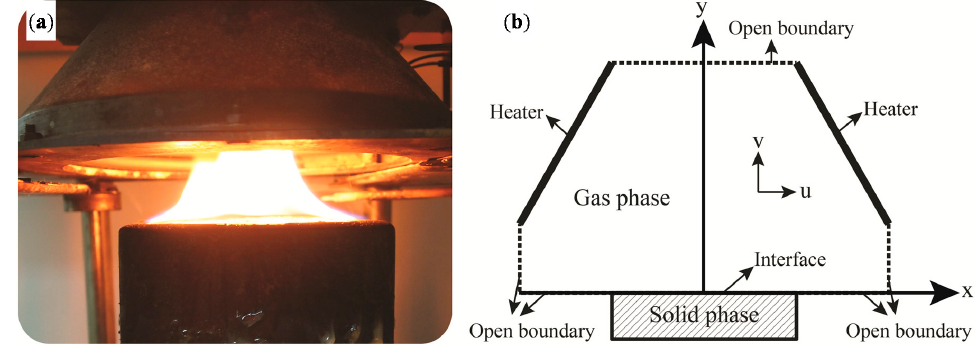
Figure 1. Cone calorimeter: ( a ) experimental setup; and ( b ) computational domain of FiresCone. Table 1. A list of experimental and numerical designs and parameters .